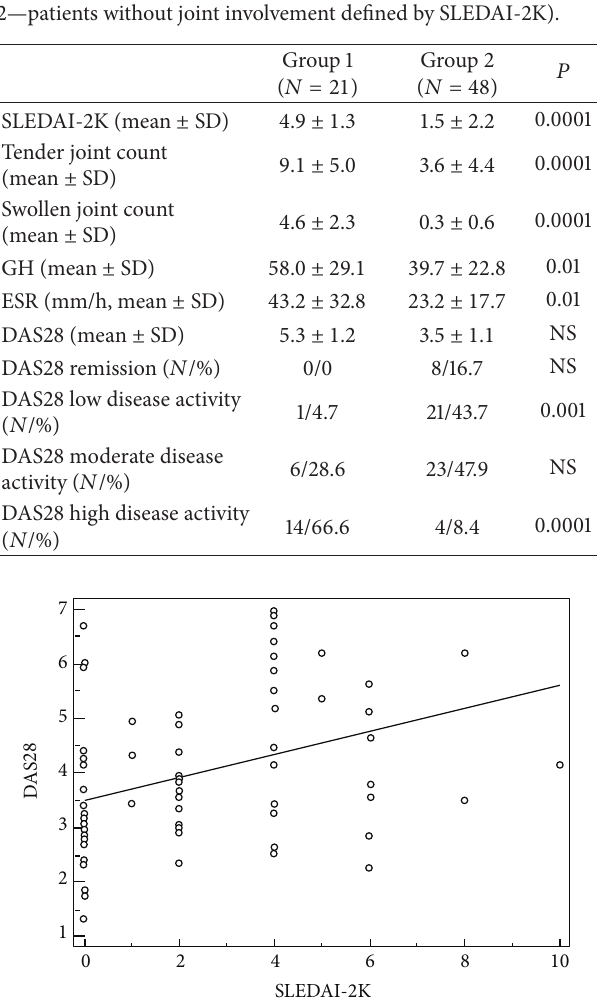
Figure 2: Correlation between DAS28 values and SLEDAI-2K ( 𝑟 = 0.4 ; 𝑃 = 0.0006 ).